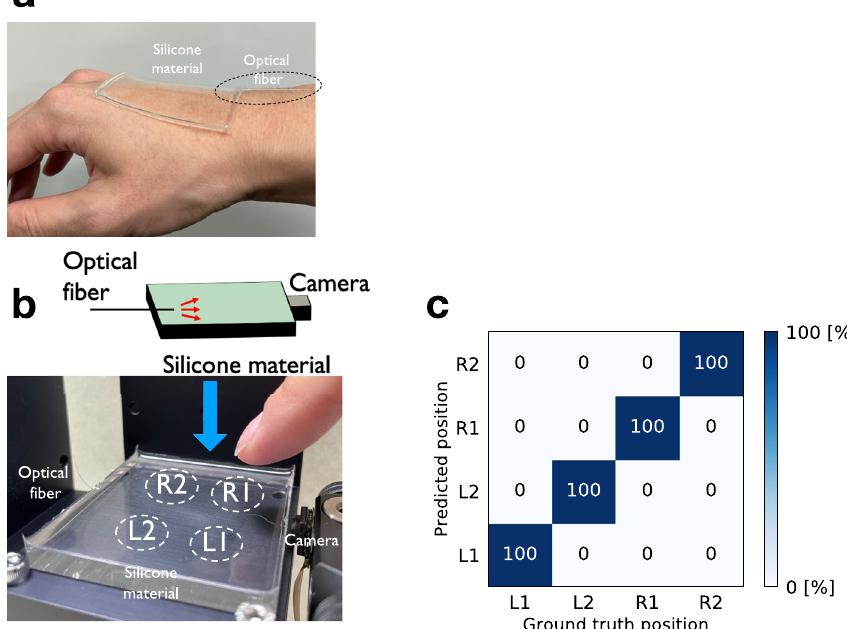
Figure 7. Human–machine interface. The interface device consists of a thin transparent soft material, optical fiber, and miniature camera. (a) A thin silicone material can be fitted on the human hand. (b) Interface device. The device can detect four positions, indicated by L 1, R 1, L 2, and R 2, where the silicone material is pressed by a human finger. (c) Classification accuracy. The contact position can be identified with 100 % accuracy after